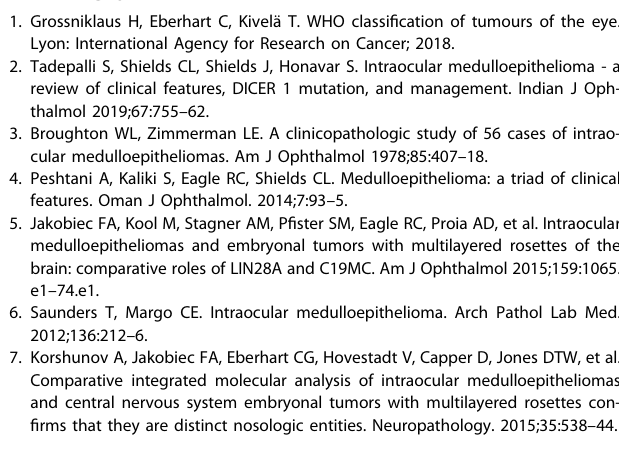
Fig. 6 Morphological, immunohistochemical, and molecular features of Rax - creER T2 ::Ctnnb1(ex3) fl / + SmoM2 fl / + ( RBS ) ocular lesions match with IO-MEPL as opposed to retinoblastoma. a Morphology of murine RBS lesion after tamoxifen administration on day E8.5 (left column) compared to IO-MEPL (middle column) and human retinoblastoma (right column). Flexner – Wintersteiner – Rosettes in retinoblastoma were smaller in comparison to the pseudostrati fi ed rosettes of IO-MEPL and RBS ( fi rst row). IO-MEPL and RBS stained strongly for MAP2C, while rosette structures consistently lacked staining signal. In contrast, retinoblastoma displayed strong MAP2C positivity with most prominent staining intensity towards the luminal surfaces of rosettes (second row). SOX2-positive cells were found in IO-MEPL and RBS in a scattered distribution with occasional accentuation of staining intensity in association with rosettes or rosette-like structures, while SOX2 staining was negative in Retinoblastoma (third row). OTX2-positive cells were occasionally found in IO-MEPL in association with rosettes or rosette-like structures and in RBS in the residual retina and NBL-like rosettes. In contrast, retinoblastoma stained negative for OTX2 (fourth row). Scale bar is 100 µm. b Hierarchical clustering based on cross-species harmonized gene expression data of this study, GSE30074 [33] and GSE172170 [34]. Ocular lesions of RBS mice formed a distinct cluster with closest similarity to human IO-MEPLs, but not human retinoblastomas. The analysis was based on signi fi cantly differentially expressed genes of IO-MEPL vs. retinoblastoma ( t test). Established Shh-MBs from hGFAP-cre::SmoM2 fl / + mice formed a distinct cluster with SHH-MBs of this study and GSE30074. Cross-species gene expression analysis was based on 704 common genes of the human and mouse Nanostring PanCancer pathway panels as well as the Affymetrix Human Gene 1.0 ST Array [HuGene-1_0-st]. Distance method used was Pearson correlation, dendrogram drawing method used was average linkage. c – e Gene set enrichment analysis (GSEA) revealed persisting overrepresentation of both WNT and SHH signaling pathway genes in IO-MEPLs vs. G4-MB after data harmonization ( c ) and signi fi cant enrichment of both pathways in IO-MEPLs compared to retinoblastoma ( d , e ). Analysis was performed based on prede fi ned Nanostring gene sets. Asterisks indicate signi fi cance: p value <0.05*. f – i Box plots demonstrate signi fi cantly upregulation of both CTNNB1 and SMO in IO-MEPL compared to retinoblastoma. Gene expression comparisons were based on the datasets after Combat harmonization ( f , g ) and on the original datasets normalized to housekeeping genes (HK, h , i ). Whiskers extend from min to max values. Asterisks indicate signi fi cance: p value <0.001***, Welch ’ s t